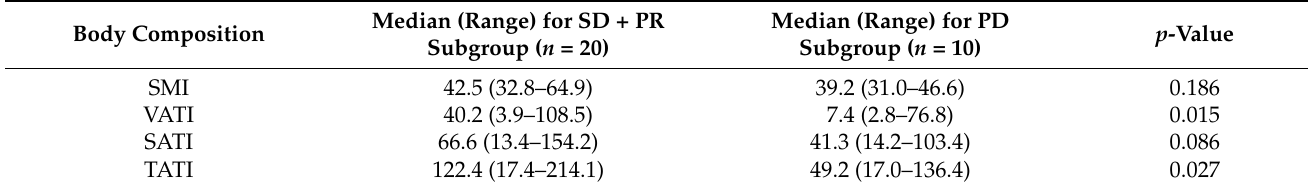
Table 2. Relation between best response and pre-therapy index variation.